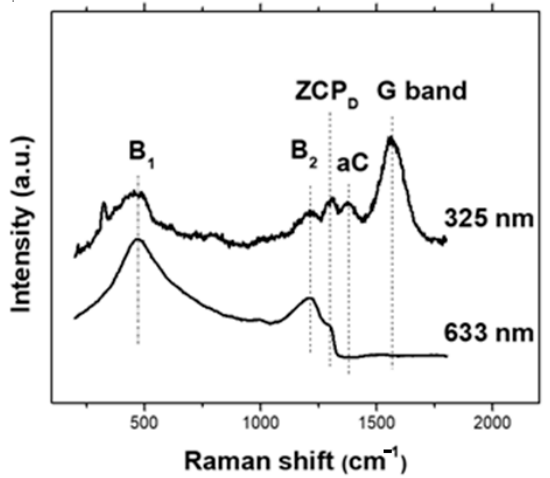
Figure 2. Raman spectra of the BDD film acquired at 325 nm and 633 nm excitation (B 1 and B 2 —boron incorporation related maxima, ZCP D —zone center phonon mode of cubic diamond, aC—amorphous carbon, G band—graphite band related to sp 2 carbon).